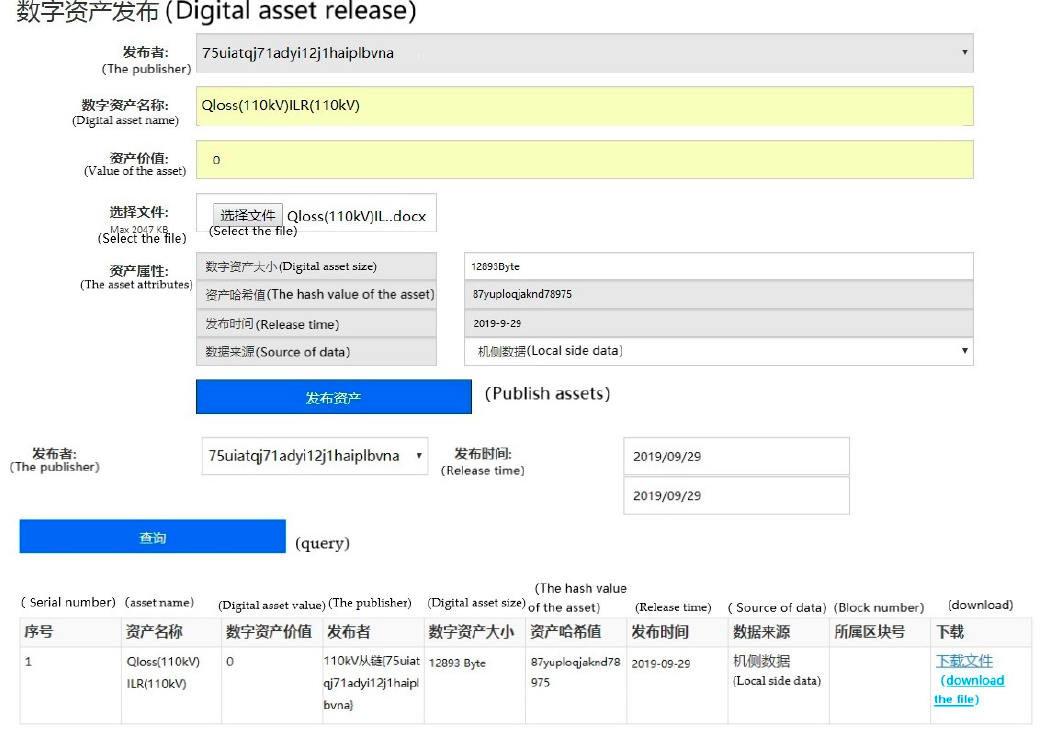
Figure A5. Chain35kV releasing scheduling data, and data asset information downloading.